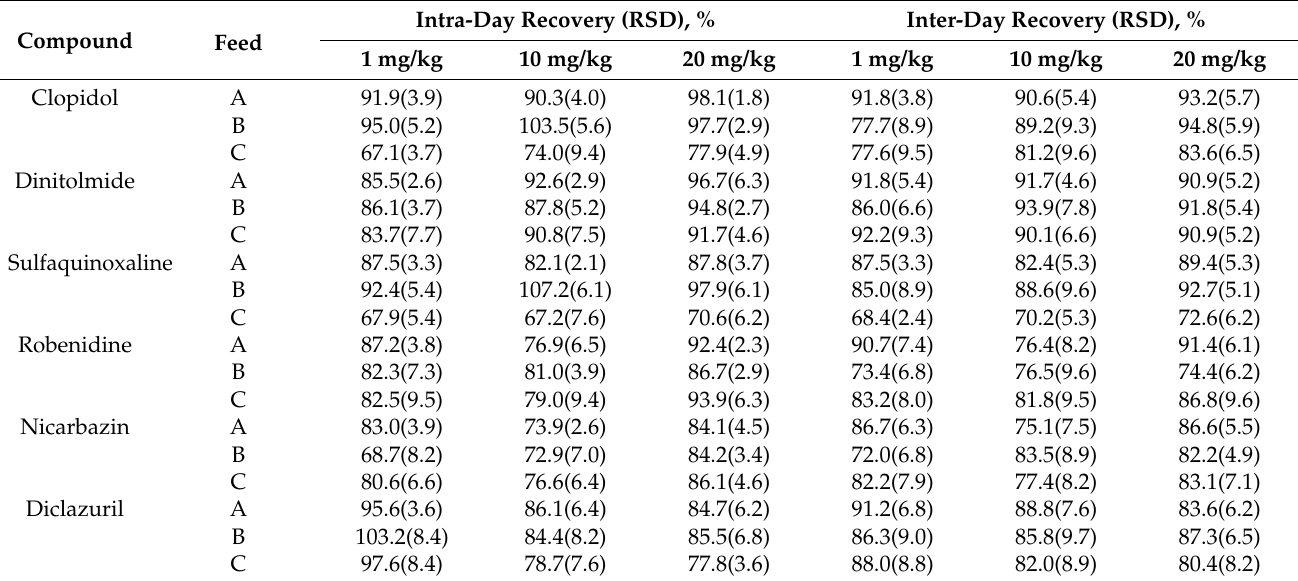
Table 1. Recovery and precision of six coccidiostats in feed samples (n = 6) a